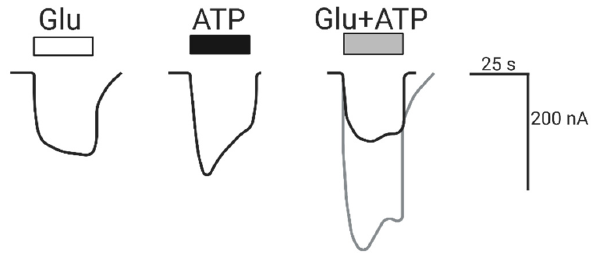
Figure A5. P2X4–NMDAR inhibition is observed at low current responses. Representative current recorded from an individual oocyte expressing P2X4 and GluN2B-containing NMDARs, responding to: Glu (2 µM), ATP (5 µM), or Glu and ATP (2 µM and 5 µM, respectively). The predicted additive response (grey line) is calculated as the sum of the individual Glu and ATP induced currents.